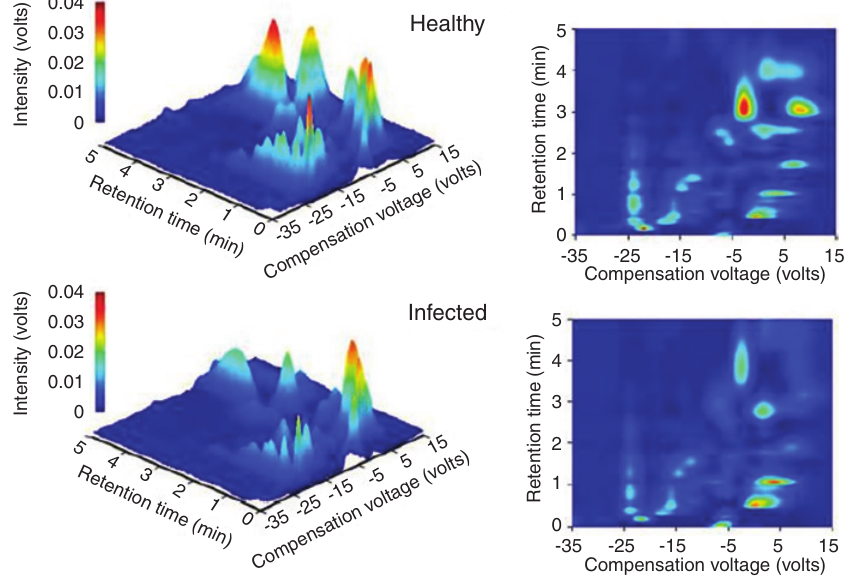
Figure 2: GC-DMS spectral identification of the VOC feature between healthy and infected